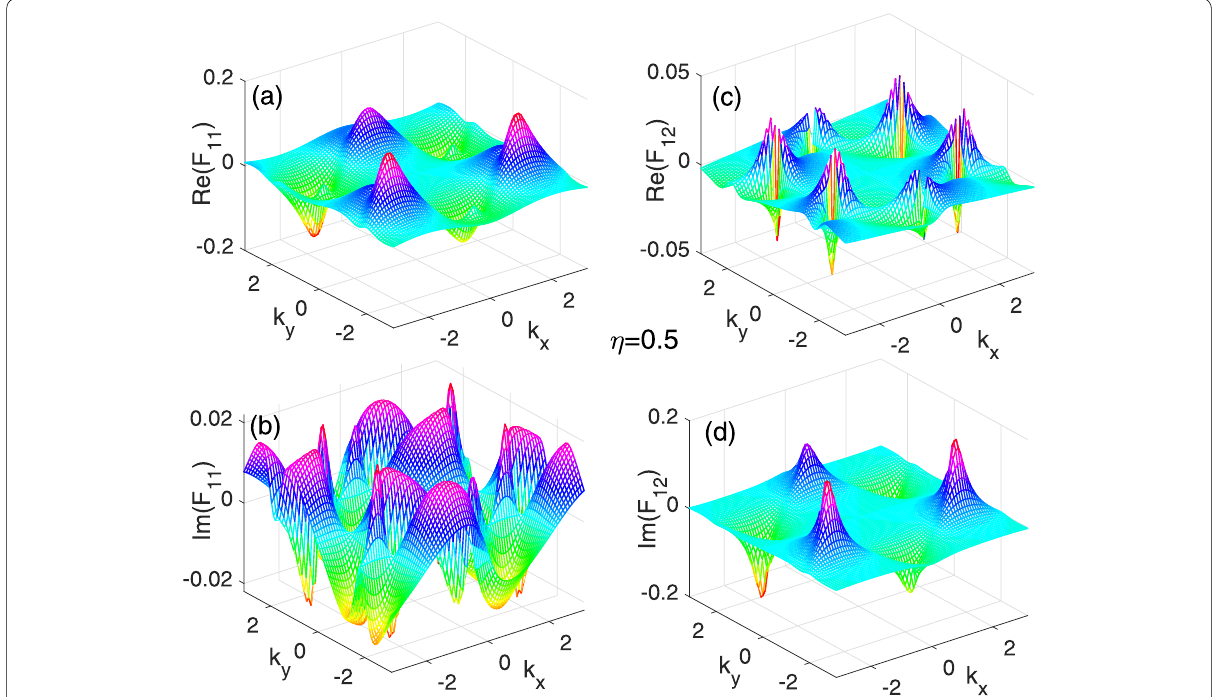
Fig. 3 (Color online): The complex Berry curvatures in the Brillouin zone for the parameter parameters η = 0.5 . a and b are the real and imaginary parts of the diagonal component of the complex Berry curvature F 11 , respectively. c and d are the real and imaginary parts of the off‑diagonal complex Berry curvature F 12 ,